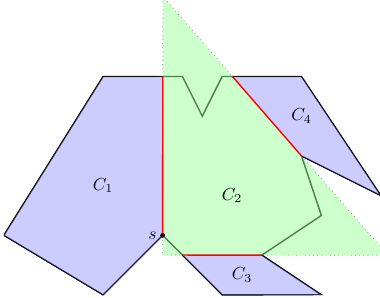
Figure 6. Motorcycle cells ( C 1 to C 4 ) induce (possibly infinite) convex polygons by extending their bordering motorcycle edge segments. (The green area shows the induced polygon for the cell C 2